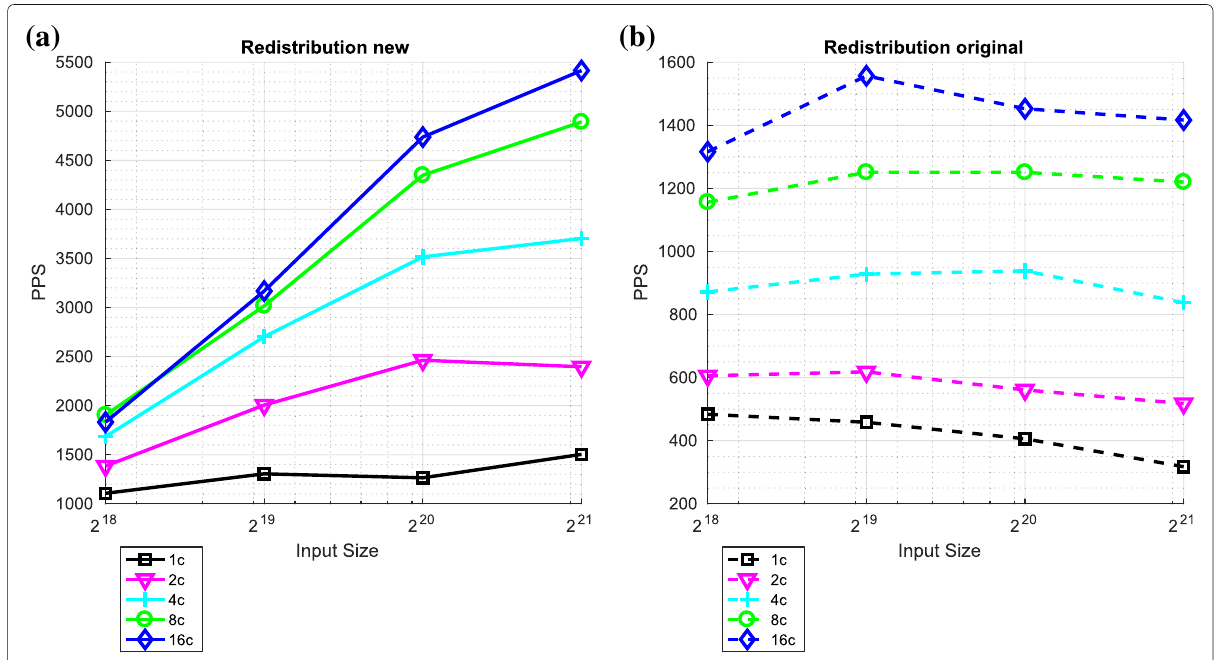
Fig. 12 Performance of the two variants of the redistribution component (using Spark). a Redistribution O (cid:2) (cid:3) N ( log ) 3 O 2 N P